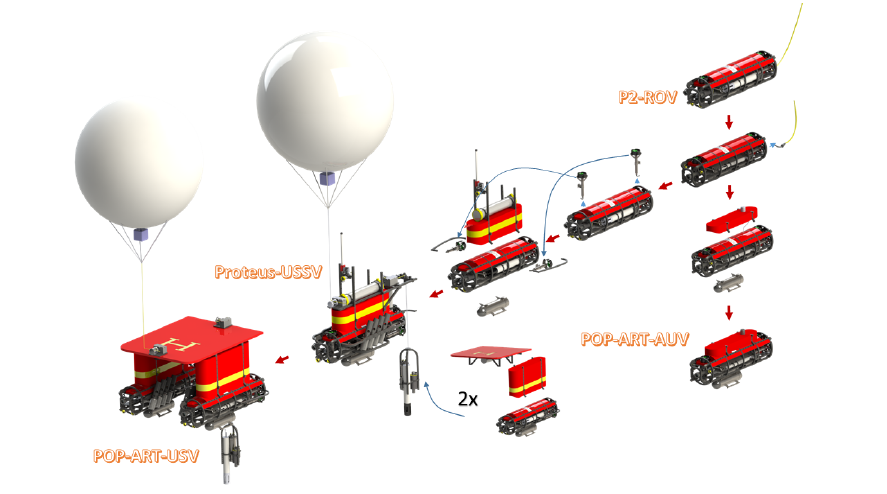
Figure 9. POP-ART (POlar Portable Autonomous Robotic Technology): modular reconfigurable UMV (Unmanned Marine Vehicle) for polar